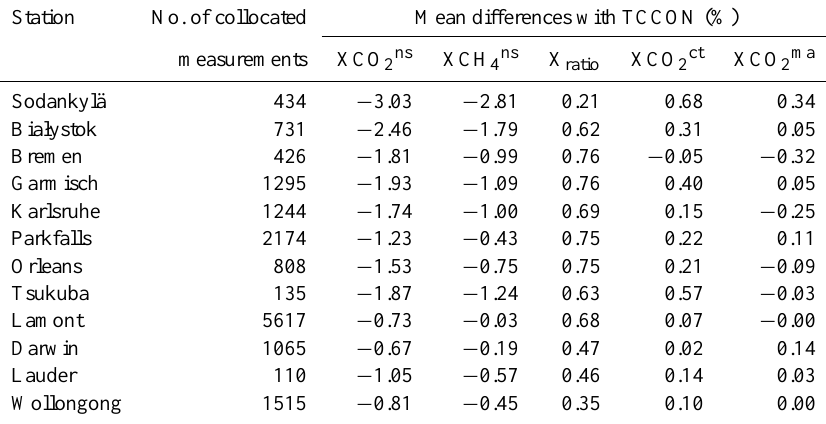
Table 1. TCCON validation of the components of XCH proxy (see Eq. 2). The numbers represent mean percentage differences with TCCON 4 (weighted with TCCON + GOSAT error). A negative number means that the satellite retrieval is lower than TCCON. Data from these stations were used: Sodankylä (Kivi et al., 2014), Białystok (Deutscher et al., 2014a), Bremen (Deutscher et al., 2014b), Garmisch (Sussmann and Rettinger, 2014), Karlsruhe (Hase et al., 2014), Parkfalls (Wennberg et al., 2014a), Orleans (Warneke et al., 2014), Tsukuba (Morino et al., 2014), Lamont (Wennberg et al., 2014b), Darwin (Griffith et al., 2014a), Lauder (Sherlock et al., 2014), and Wollongong (Griffith et al., 2014b), and are arranged from north to south (for TCCON site locations, see Fig. 1).